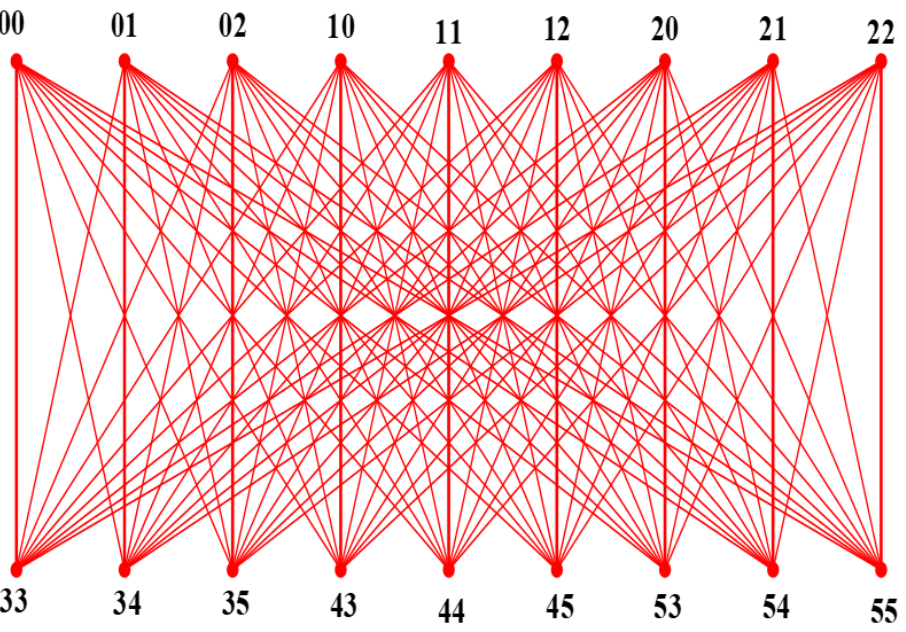
Figure 9. The bipartite circulant graph 𝐶 18,9 .